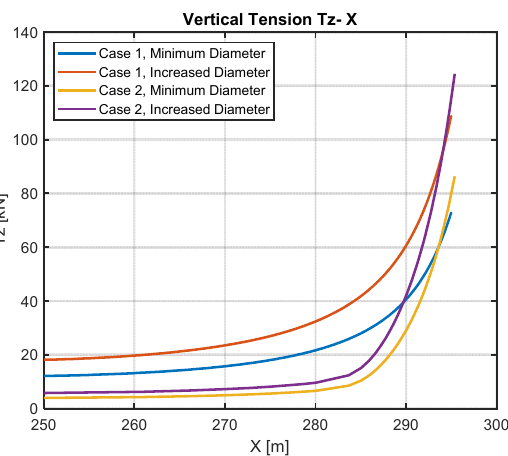
Figure 10. Vertical mooring tension at the fairlead as a function of horizontal distance from the anchor to the buoy.